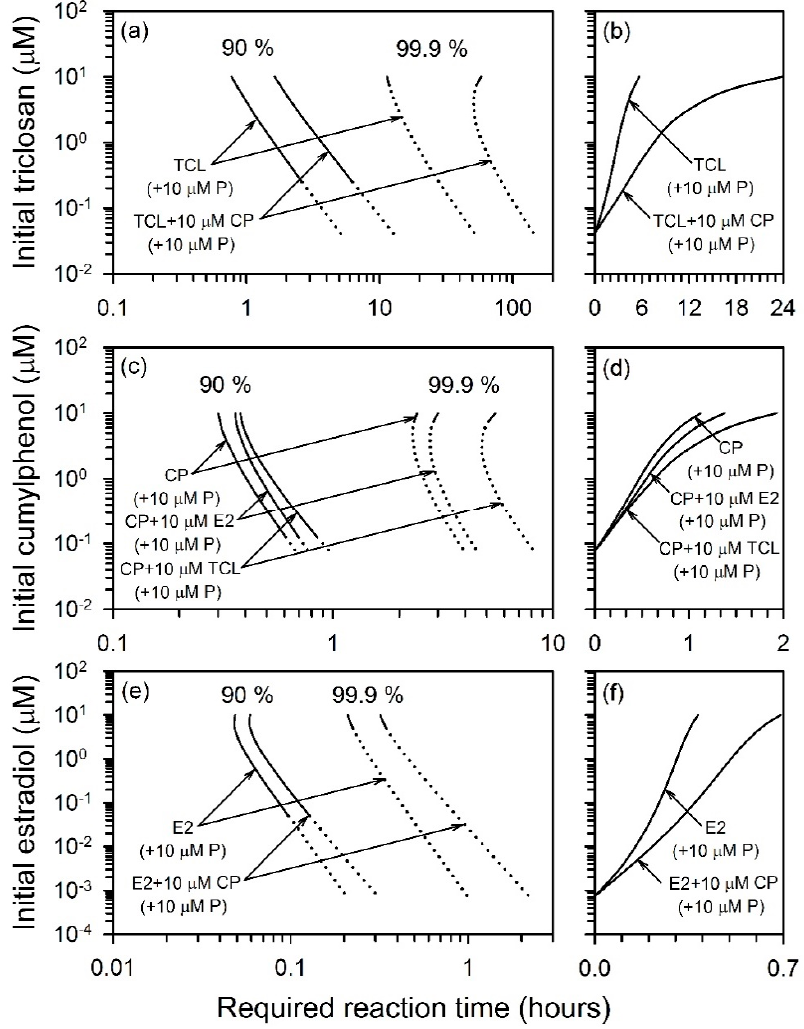
Figure 7. Model predictions of (1) reaction times required to achieve 90% or 99.9% conversion of target substrates in batch reactions for a range of initial target substrate concentrations, both with and without the presence of 10 µ M secondary substrates ( a , c , e ); and (2) reaction times required to achieve final concentrations of the targeted substrate equal to 100 times the predicted no-e ff ect concentration (PNEC) ( b , d , f ). Model predictions are shown for reactions of triclosan (TCL), cumylphenol (CP), and estradiol (E2) both as target and secondary substrates in the presence of 125 nM laccase. The insignificant e ff ect of phenol (P) as a secondary substrate is also shown. Solid portions of lines represent predictions within the range of calibration / verification of the model, and dotted lines represent predictions outside of this range.